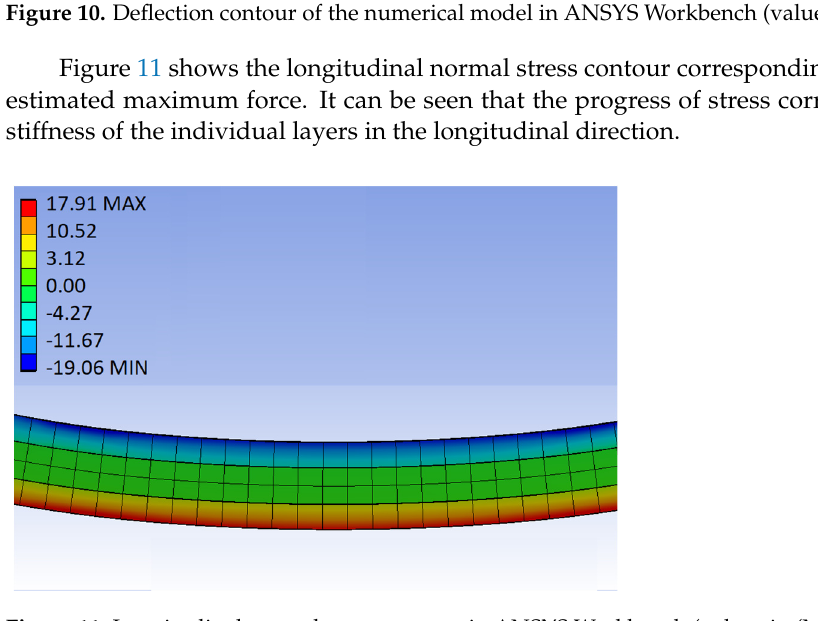
Figure 11. Longitudinal normal stress contour in ANSYS Workbench (values in (MPa)).